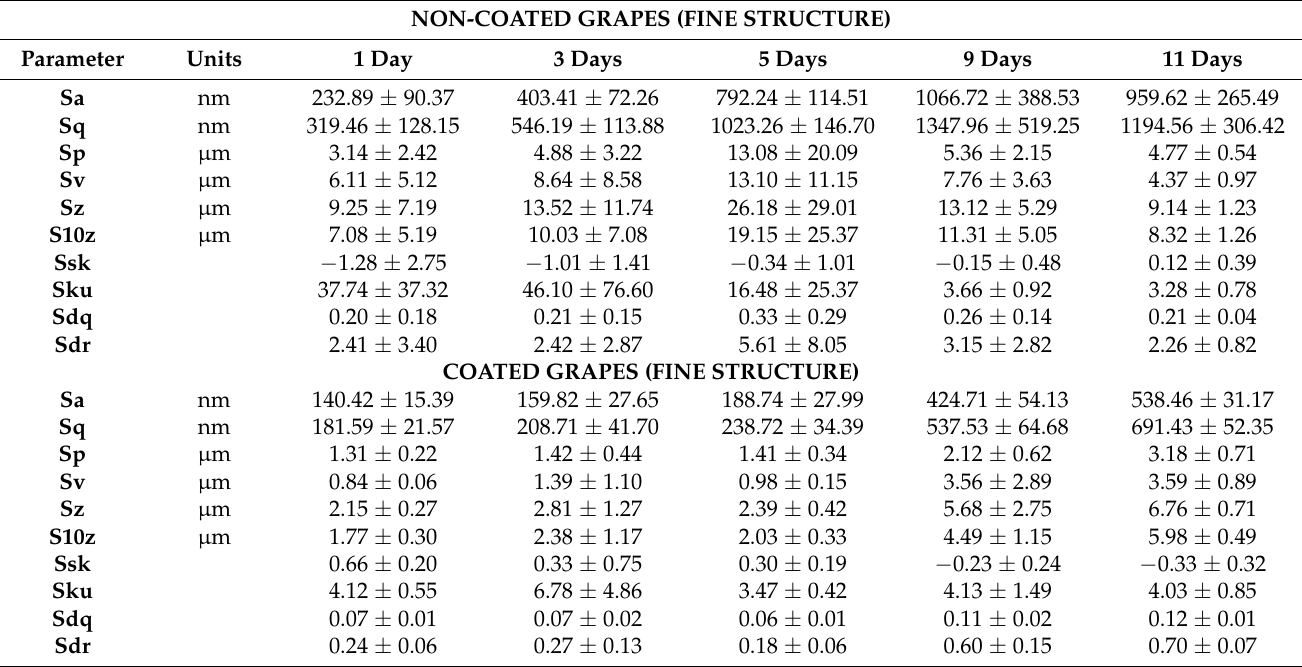
Table 2. Roughness parameters for non-coated and coated grapes eliminating the shape effect. NON-COATED GRAPES (FINE